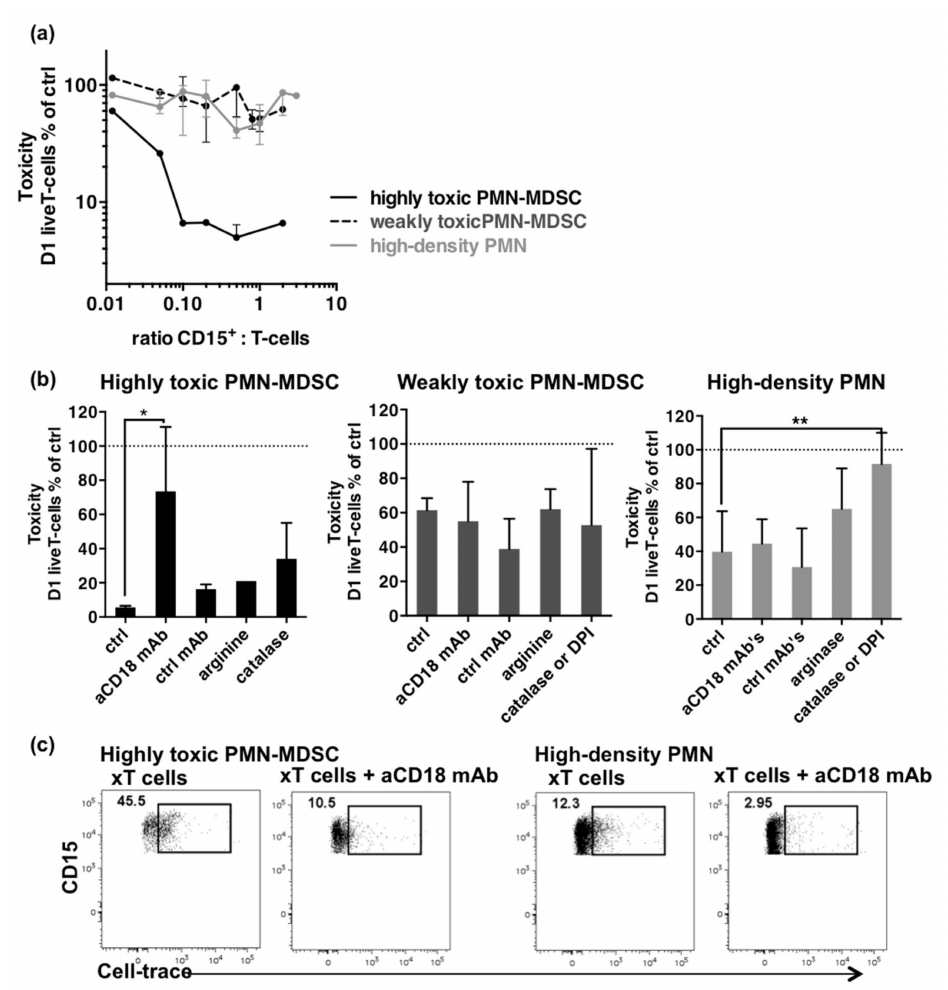
Figure 3. Mechanisms involved in cytotoxicity. ( a ) T cell survival according to CD15 + to T cell ratios of highly toxic PMN-MDSCs (black line), weakly toxic PMN-MDSCs (dashed line), and patients’ high-density PMNs (grey line). Data come from different experiments (highly toxic PMN-MDSCs, n = 6; weakly toxic PMN-MDSCs, n = 11; high-density PMNs, n = 16). Ratios were calculated from aliquots stained on day 0. Median and IQR. ( b ) Restoration of T cell survival in cytotoxicity assays by anti-CD18 mAb’s, control mAb’s (ctrl), arginine, and catalase or DPI. Highly toxic PMN-MDSCs, n = 4 for aCD18 and ctrl mAb’s; n = 1 for arginine; n = 2 for catalase. Weakly toxic PMN-MDSC, n = 10. High-density PMNs, n = 12. Median and IQR. p -values of Wilcoxon matched pair-tests are indicated on top of pairs: *, p < 0.05; **, p < 0.01. ( c ) Trogocytosis of T cells by PMN-MDSCs. Dot plots show expression of the Cell-trace T cells dye in highly toxic PMN-MDSCs and high-density PMNs after overnight co-cultures without or with anti-CD18 mAbs. PMNs were gated as live CD3 − CD15 +